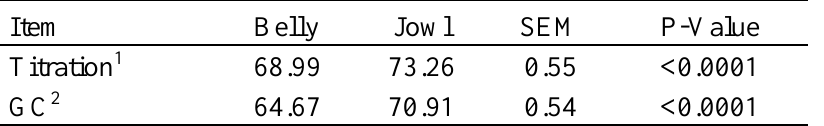
Table 8. Least squares means for iodine values of belly and jowl fat independent of